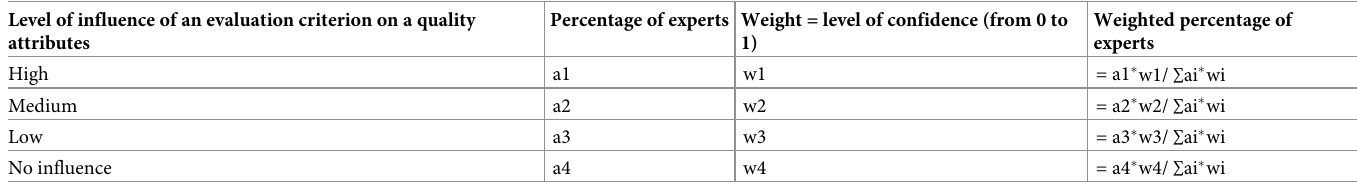
Table 1. Calculation of the weighted percentage of experts used for the analysis of the experts’ elicitation. The weights represent the level of confidence of the experts in their answers. This calculation was used to validate the level of influence of evaluation criteria on the six quality attributes. Level of influence of an evaluation criterion on a quality